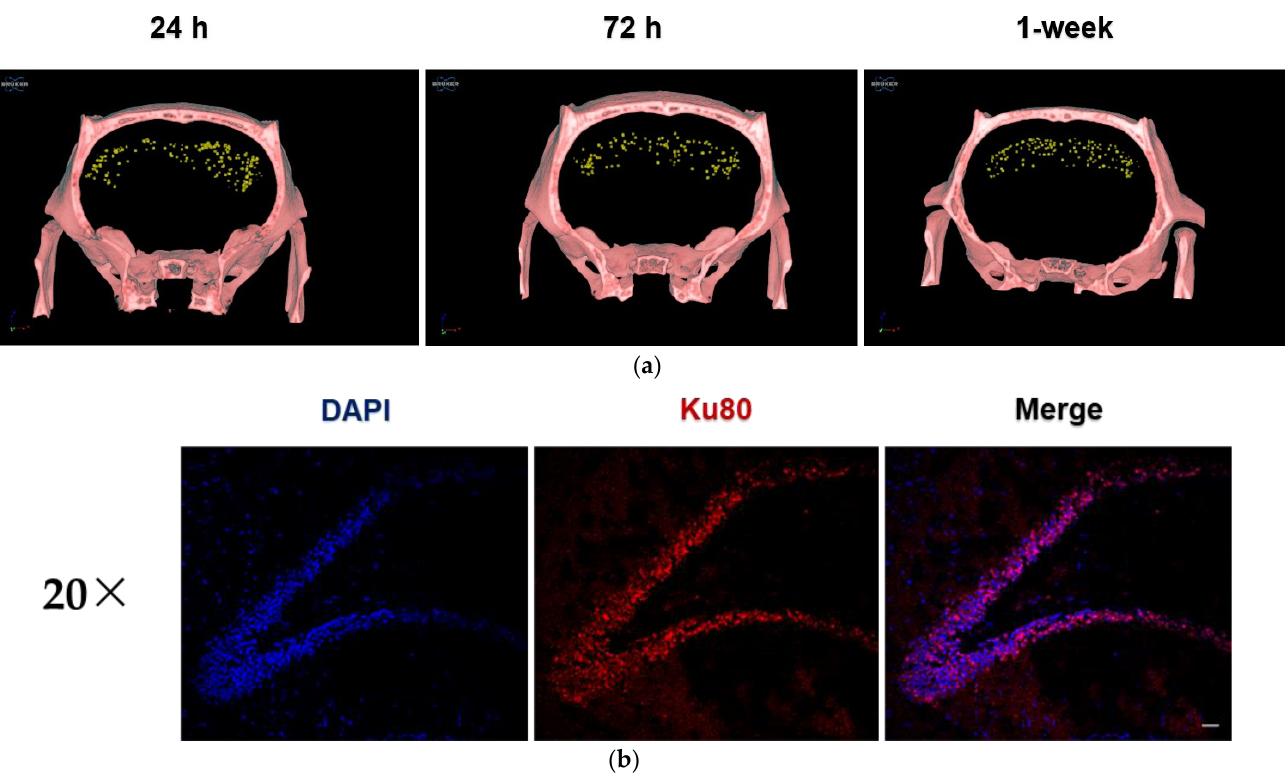
Figure 3. Tracking PLX-PAD cells migration within the brain. ( a ) Representative in vivo micro- CT scans in the Coc-nPAD group. Demonstrative micro-CT scans 24 h, 72 h, and 1-week post-IN treatment. Cell spreading into the brain is evident at 24 h and represented less in 72 h and 1 week; ( b ) PLX-PAD cell localization in the dorsal DG 1-week post-treatment . Representative images of the dorsal DG from Day 22, 1-week post-IN treatment show PLX-PAD localization; Scale bar: 50 µ m. DG sections were stained with DAPI and Ku80 (a human-specific antibody recognizing PLX-PAD